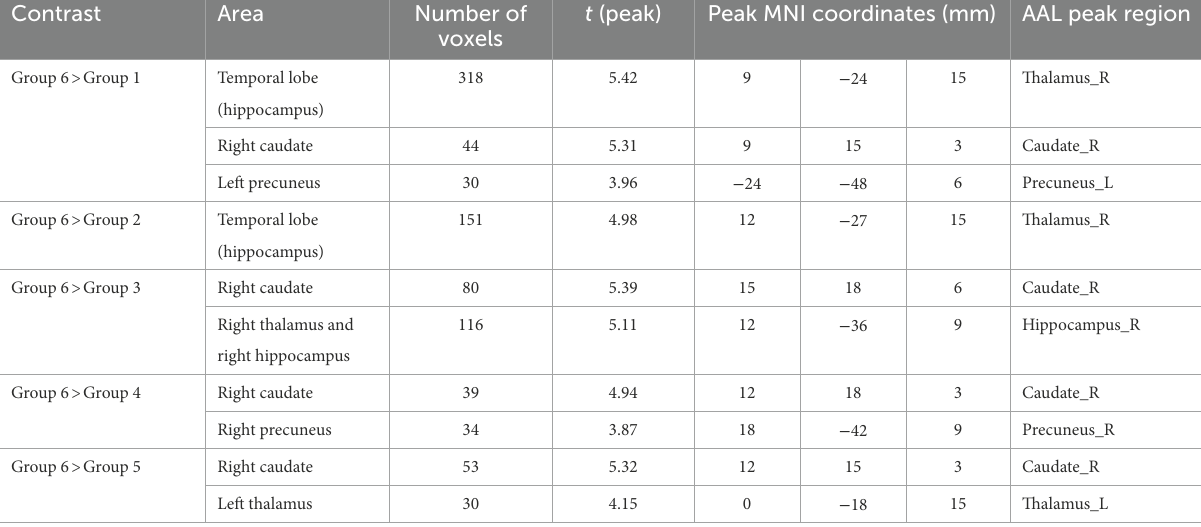
TABLE 4 Significant between-group differences in ReHo with their peak localization in MNI coordinates and the corresponding AAL region of interest (ROI). Contrast